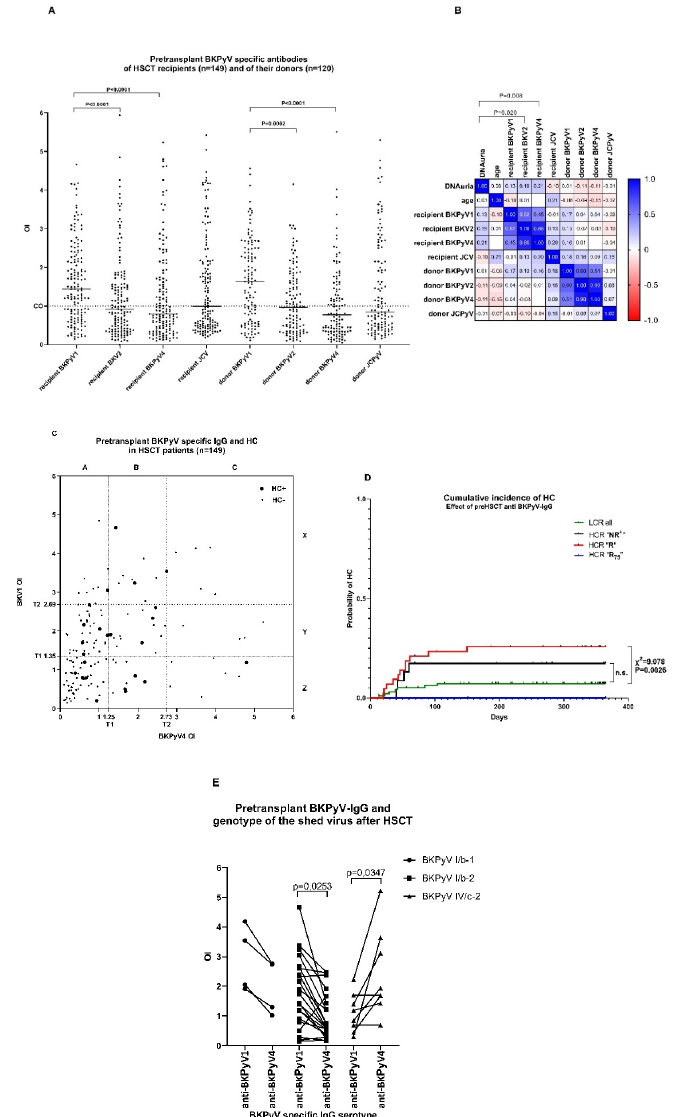
Figure 2. Polyomavirus-specific antibodies of HSCT recipients and donors and their relevance for BKPyV infection in PBIHC study. ( A ) Pretransplant antibodies specific for BKPyV types 1, 2, 4 and JCPyV were measured in serum or plasma by ELISA. Positive samples have OI ≥ 1. The significance of differences between the median of OI was analysed using the paired nonparametric Wilcoxon test. ( B ) Spearman correlation analysis of anti-BKPyV and JCPyV IgG of recipients and donors, maximal DNAuria during the first year after transplantation and their age. The heatmap shows the Spearman correlation matrix and exact Rs values. ( C ). Plot of pretransplant anti-BKPyV 1 and 4 IgG in individual patients of the PBIHC study group ( n = 149). The large symbols stand for patients with HC. The dotted line starting at T1 represents the guaranteed threshold of positivity for BKPyV 1 and 4 (mean of nonreactive samples of values < OI = 1 + 3 s.d.). The dotted line starting at T2 represents the 75th percentile of all seropositive samples > OI = 1. ( D ) Cumulative incidence of haemorrhagic cystitis (HC) in HSCT recipients stratified according to anti-BKPyV-IgG levels and clinical risk factors ( n = 149). The HC rate in the HCR group with medium levels of anti-BKPyV IgG was 34.3%. Survival curves were compared using the LogRank (Mantel–Cox) test. ( E ) Pretransplant serotype specific IgG correlate with the genotype of excreted virus after HSCT. The genotype was determined in urine samples of patients with very high BKPyV load >10 9 ( n = 33). The significance of the difference between anti-BKPyV1 and anti BKPyV4-IgG levels was determined by the Wilcoxon matched-pairs signed rank